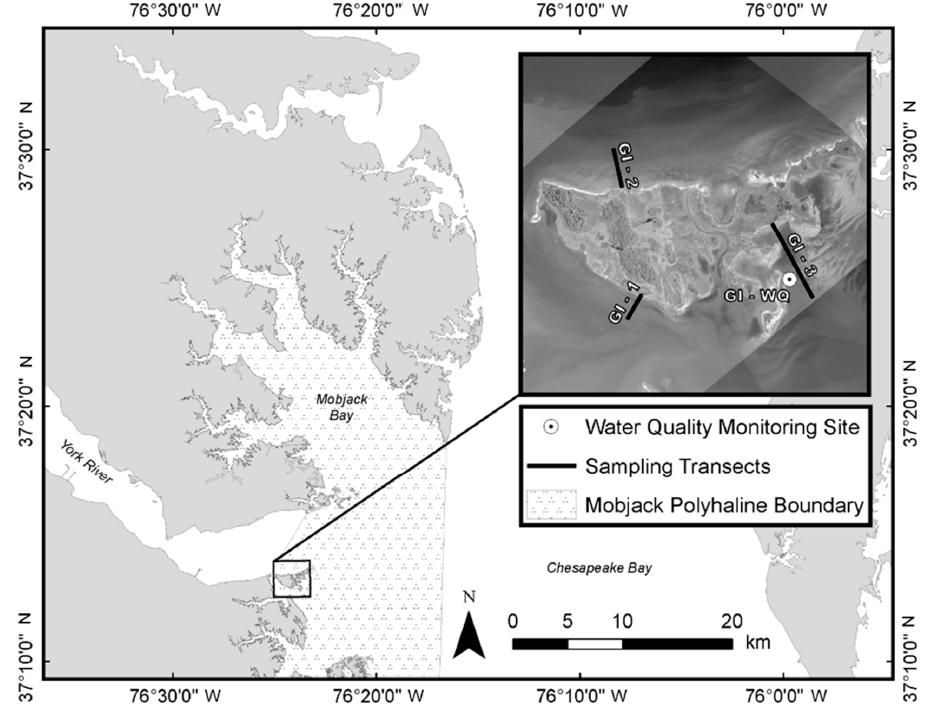
Figure 1. Site map including Goodwin Islands sampling transects (GI-1, GI-2, GI-3), water quality monitoring location (GI-WQ), and Mobjack Bay polyhaline segment boundary.